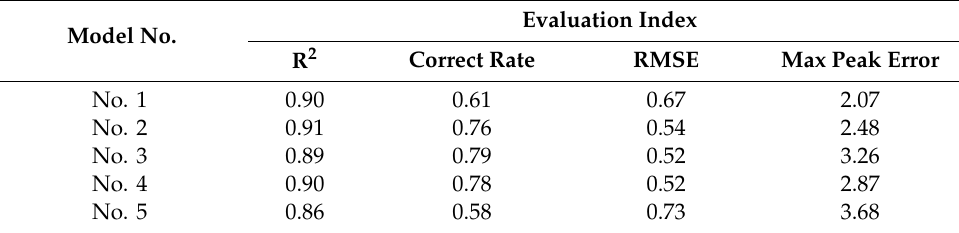
Table 13. Evaluation index value extracted only for results with a stop time of 10 min or more. Model